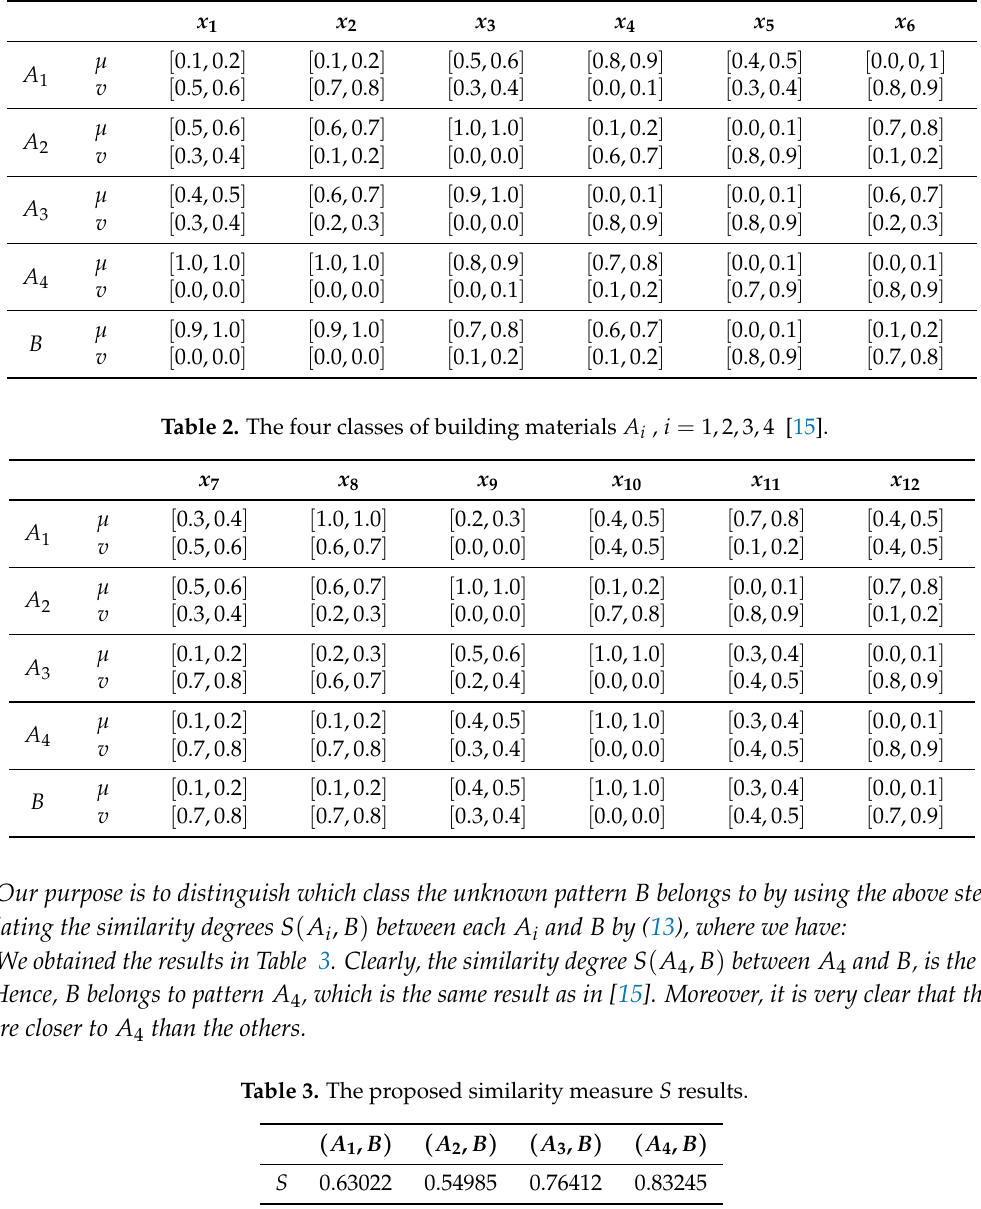
Table 1. The four classes of building materials A i , i = 1,2,3,4 [15].